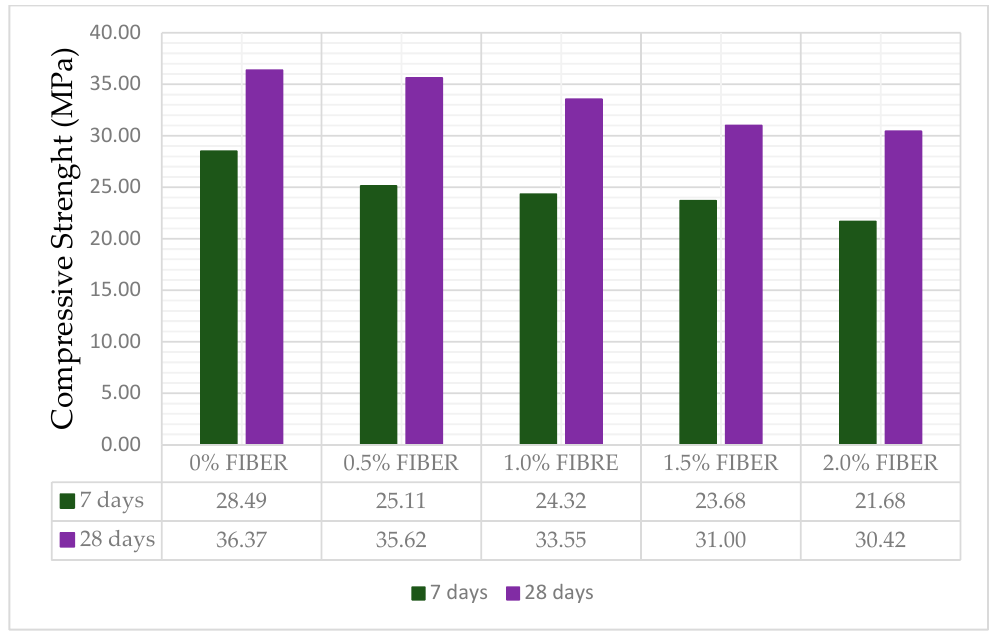
Figure 6. Compressive strength of sisal fiber-reinforced concrete.